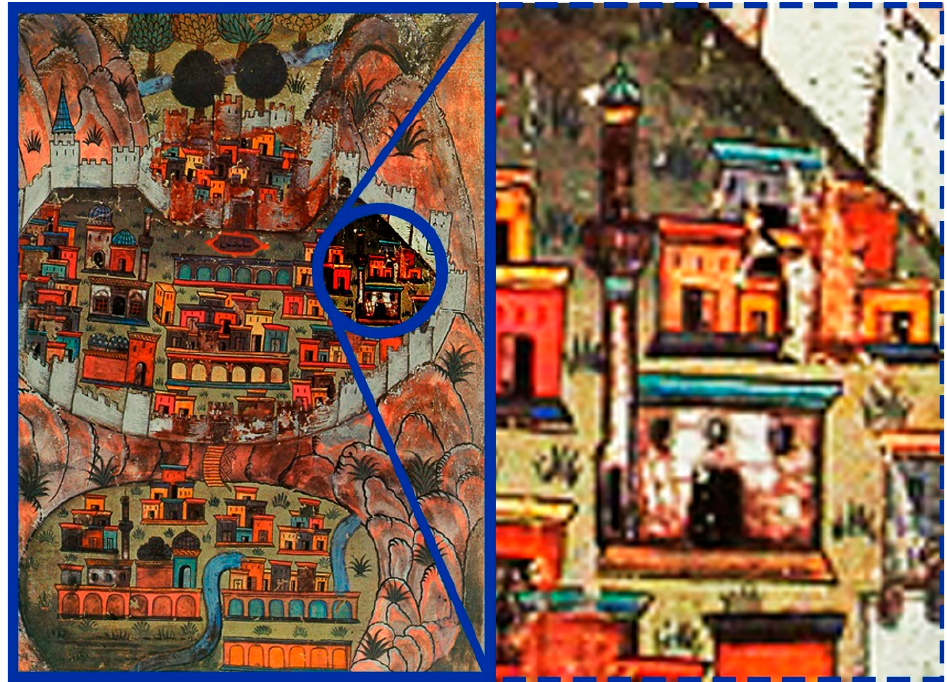
Figure 6. Matrakç ı Nasuh Bitlis miniature and the Ulu (Grand) Mosque [39]. Figure 6. Matrakçı Nasuh Bitlis miniature and the Ulu (Grand) Mosque There are data regarding the construction period of the part of the building used as a place of worship. There are two written inscriptions, which are among the most im- portant of them, in the structure. These are the inscriptions on the right side of the door from the middle of the north façade and above the door at the west entrance. In the in- scription to the right of the middle door, there is information that the building was reno-